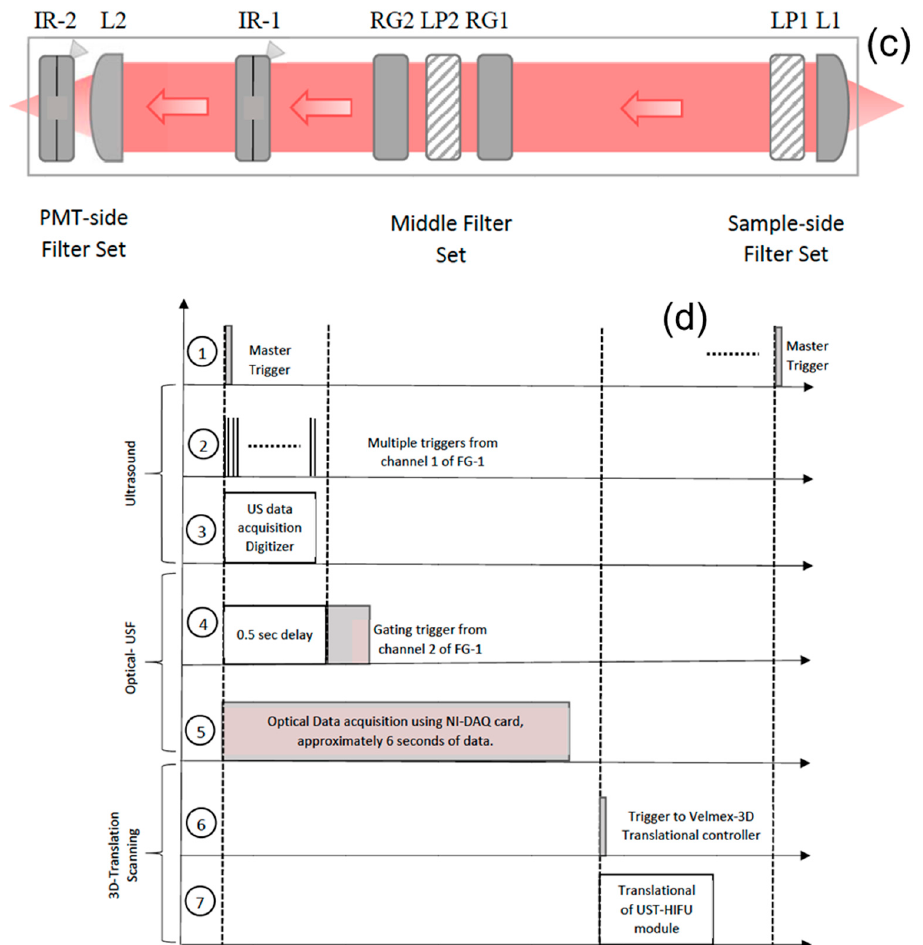
Figure 1. ( a ) Schematic diagram of the dual-modality (Ultrasound B-mode and Ultrasound-Switchable fluorescence) imaging system; ( b ) Schematic diagram depicting the dual-modality setup with dual-confocal focused HIFU with their respective projected ultrasound focuses into sample setup; ( c ) Schematic diagram of optical module of acquisition setup; ( d ) Time sequence event diagram of dual-modality imaging system. MT: Master trigger (T-1) with 0.1-Hz frequency; FG-1: Function generator, Channel-2 for gating (single cycle, pulse signal with 0.5msec delay) and Channel-1 for triggering (1-KHz, 300 cycles, pulse signal) dual-HIFU transducer module (dual-9MHz-HIFU) and Ultrasound transducer (UST) module respectively; FG-2: Function generator for driving each of the dual-HIFU(HIFU-1 and HIFU-2) by means of power amplifier (RFA-1 and RFA-2) respectively using 9MHz sinusoidal signal; Pulse T/R: pulse transmitter and receiver to drive the UST; FG-3: Function generator to modulate, at 1-KHz frequency, the excitation laser source (Laser); W: water tank to immerse the dual-HIFU-UST module and partially immerse the sample (S); ST: Silicone tube of inner diameter (ID): 0.31 mm and outer diameter (OD): 0.64 mm; 3D-TS: three dimensional translational stages; TS-MCU: 3D translational stage motorized control unit; CT-1: collimation tube to focus the excitations laser source into optical bundle (OB-1); CT-2: Optimized collimation tube to guide the collected fluorescence signal from optical bundle (OB-2) from within sample (S); PMT: photo-multiplier tube to detect the optical fluorescence signal; Pre-amp: preamplifier to filter detected optical signal from PMT; LIA: Lock-in amplifier to detect 1-KHz frequency signal from detected optical signal; NI-DAQ: National instrument data acquisition module to record optical signal; Digitizer: National instrument data acquisition module to record ultrasound signal; CB-1: communication bus to transfer ultrasound signal data; CB-2: serial communication bus to control TS-MCU; CB-3: communication bus to transfer optical signal data; T-2: pulse signal with 1-KHz frequency which serves as reference signal to LIA; T-3: single cycle digital pulse signal to trigger the movement of 3D-TS.